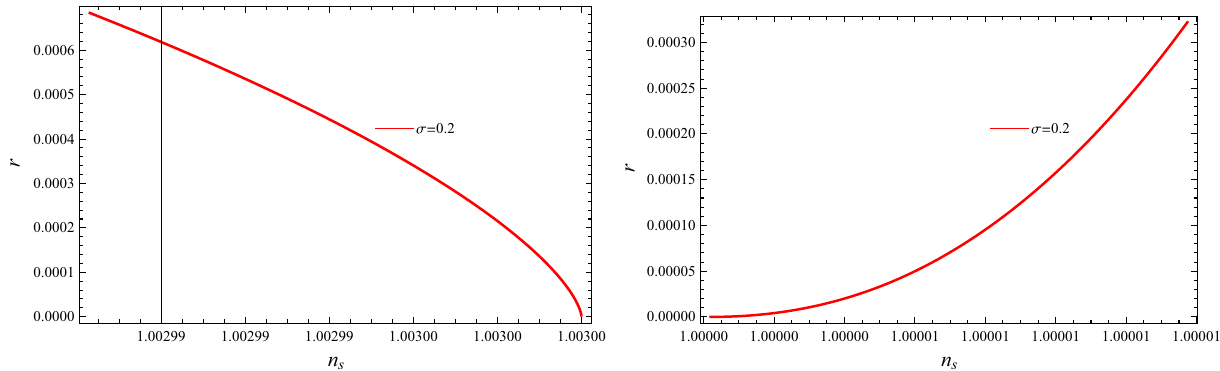
Fig. 13 Plot of r versus n s for GCCG model in weak (left panel) and strong (right panel) dissipative regimes for positive potential with n = 1 (cid:4) ( − σ 2 φ + λ ∗ φ 3 ) 2 (( 1 + α)( 1 + δ) − 1 ) ×